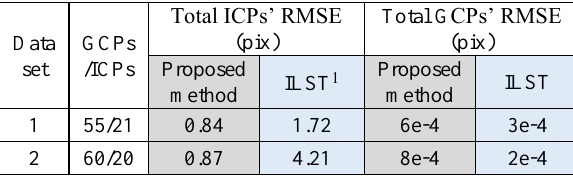
Table 1. RMSE of the ICPs and